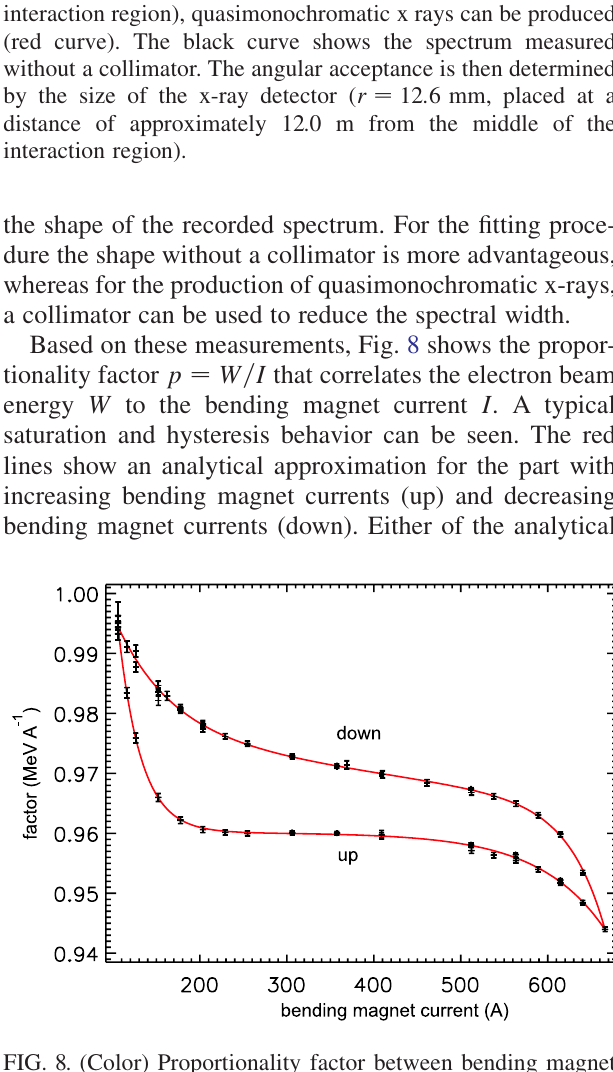
FIG. 6. (Color) Typical spectra of Compton-backscattered pho- tons for low electron beam energies.